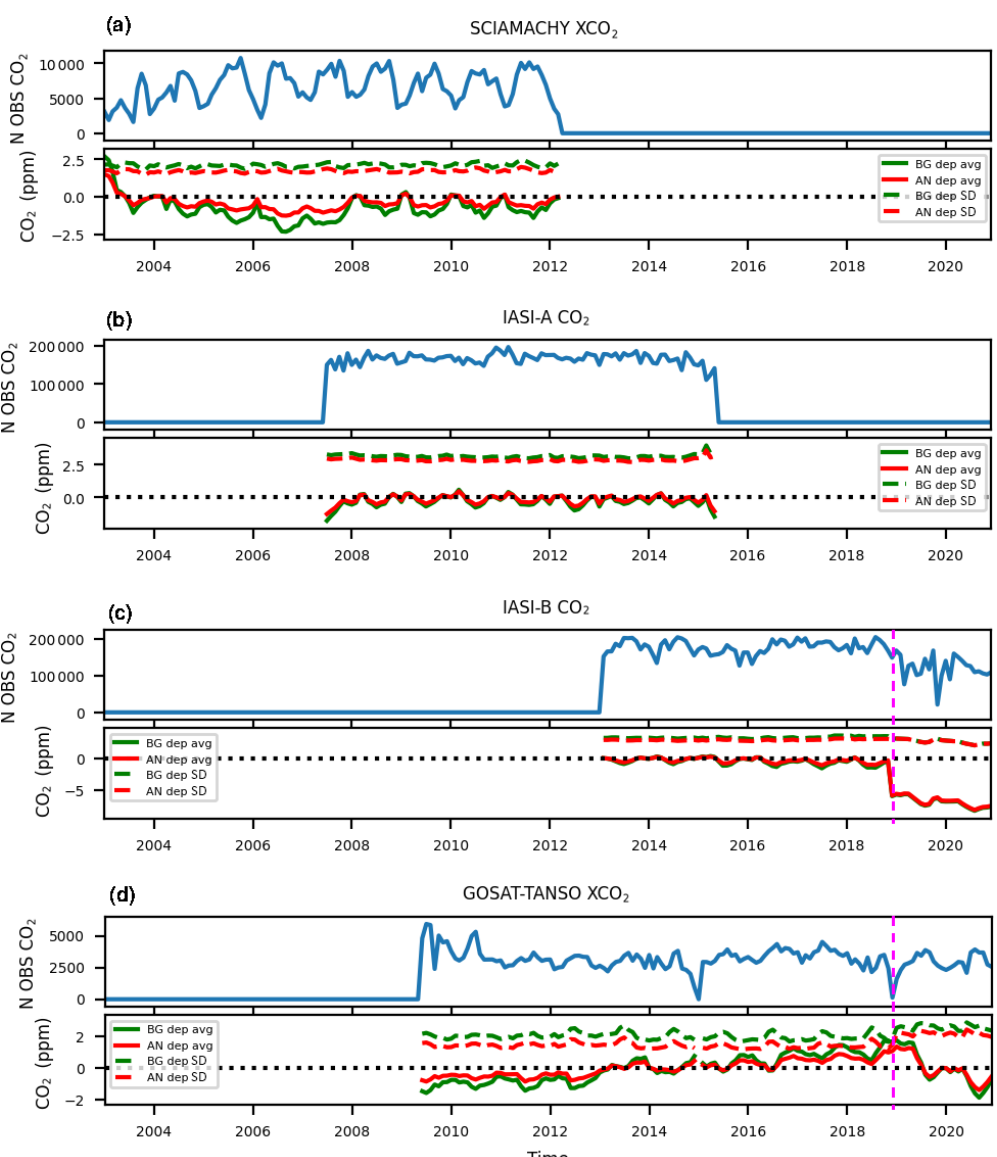
Figure 5. Time series of the global monthly number of XCO 2 satellite data (blue) and monthly mean CO 2 analysis (AN) and model background (BG) departures of the various observations (OBS) assimilated in the reanalysis (AN–OBS and BG–OBS in red and green, respectively; see the legend). The solid lines show the monthly average of the departures, and the dashed lines show the monthly standard deviations. The dashed magenta line indicates the switch to the near-real-time satellite products. Note that the range of values on the y axis varies depending on the satellite